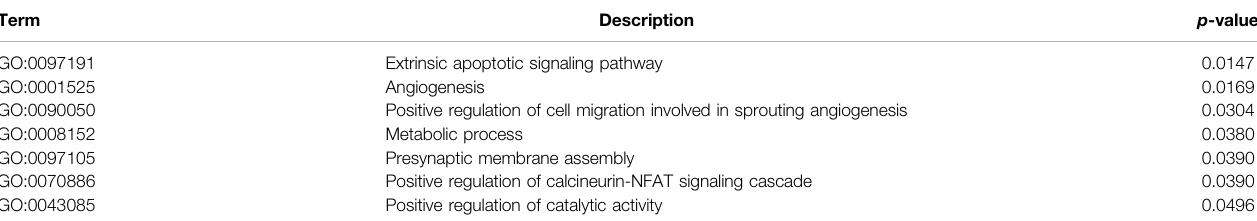
TABLE 3| GeneOntologyanalysisofBiologicalProcesses of94genesfoundintheWhiteModule,whichisnotconserved withthecontrolnetworkandcontainsthehighest number of differentially expressed genes that correlated highly with the modules. It shows that this module is enriched in cell survival and angiogenesis signaling pathways, and hence these genes are of signi fi cant interest in determining the combination mode of action. Term